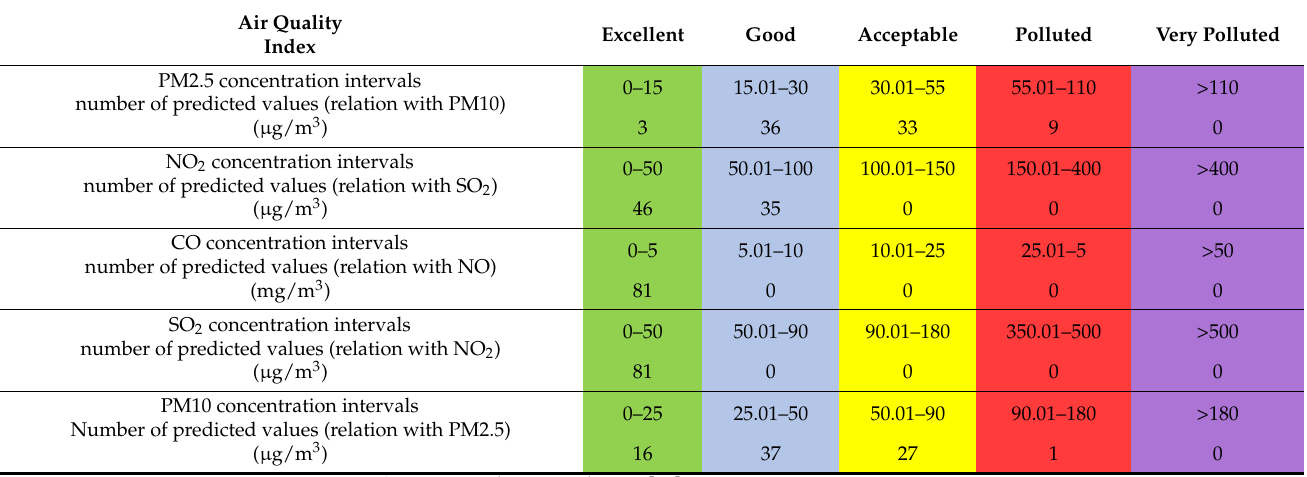
Table 7. Summarized and categorized results of predicting air pollutant values with